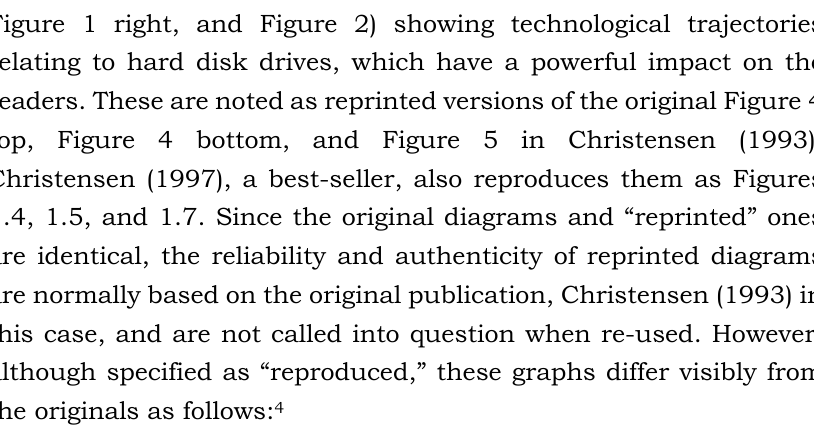
disks and ferrite heads, and thin-film disk and heads. Judging from the unit on the vertical axis, this graph would appear to indicate linear recording density 5 and represents a logarithmic axis with scales from 0.1 to 10. On the other hand, the vertical axis of Figure 1 left in Christensen and Bower (1996) is shown as a logarithmic axis with scales from 1 to 100. The same applies to Figure 1.4 in Christensen (1997). Nonetheless, the